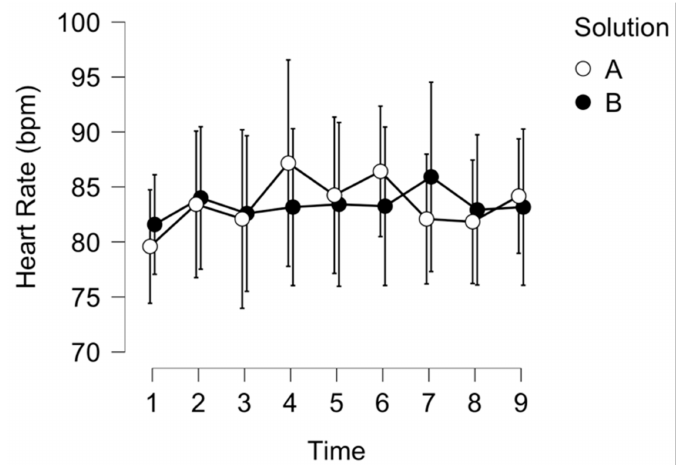
Figure 3. Participant heart rate responses following swilling solution A and B.